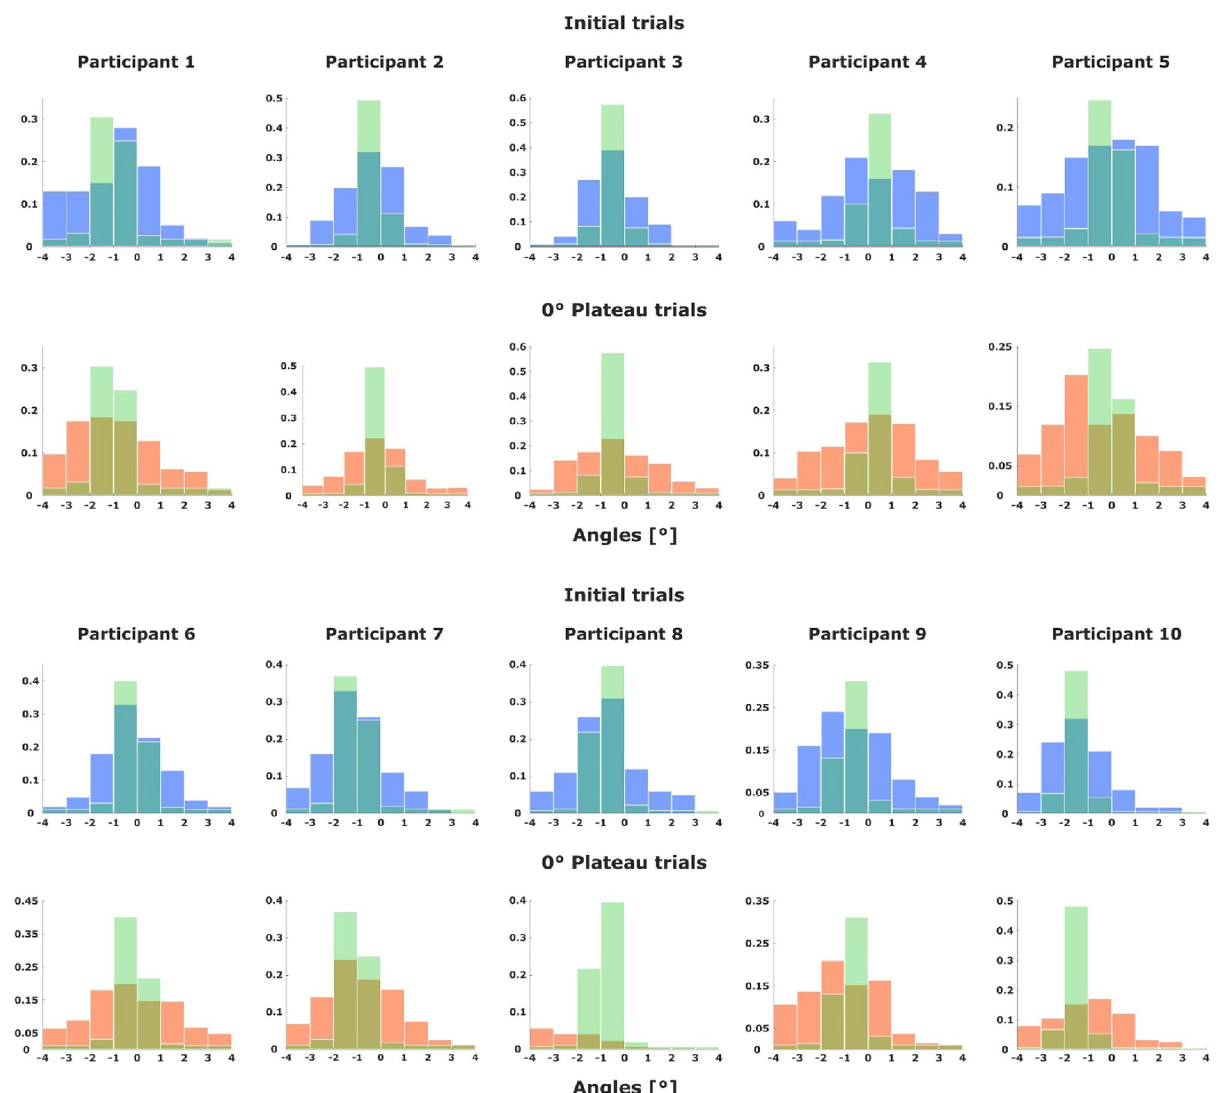
Figure 7. Comparison between participants’ behaviour in washout trials (between perturbation cycles) with the fitted equilibrium distribution (recorded before participants experienced any perturbation). The first and third rows compare the normalized histogram of the angles observed during the initial 100 trials (blue color), with the histogram of the fitted equilibrium distribution (2) over the same trials (green color). The second and the forth rows compare the same fitted equilibrium distribution (green color) with the normalized histogram of the angles observed in the 0 ◦ deviation plateaus (washout trials) which separate forward and backward protocol (red color). Note the plateau in each cycle consists of 10 points, from which we only include the last 8 to avoid large aftereffects. The application of Crooks’ theorem requires that subjects fully equilibrate between protocols, that is, in our case their behavior in washout trials should return to the fitted equilibrium behavior at the start of the experiment. Compare the discussion on condition ( ii ) on page